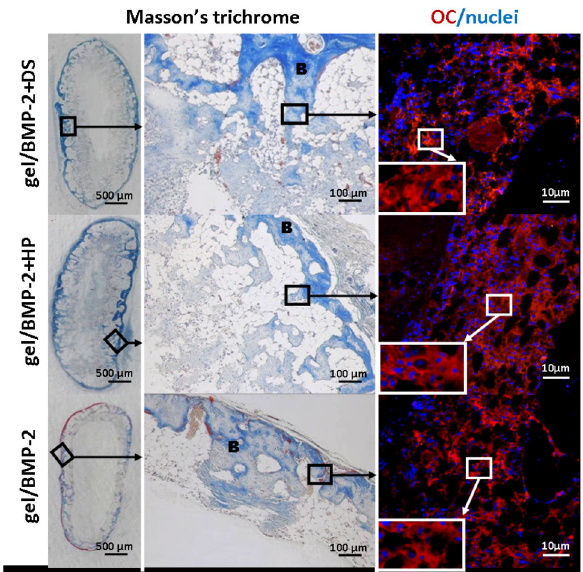
Figure 5. Elemental mapping of the surface of ectopic bone induced by gel/BMP-2+DS, gel/BMP-2+HP and gel/ BMP-2. Collagen fibers, secondary electron (SEM), calcium (Ca) and phosphorus (P) are shown. SEM was performed via gold coating. doi: